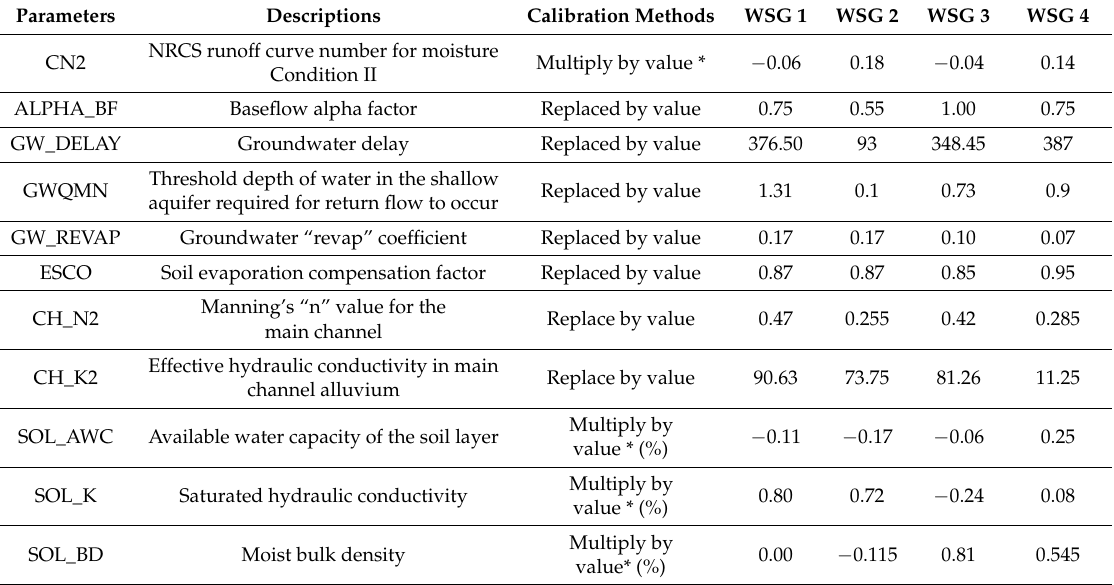
Table 2. Parameters calibrated by SWAT-CUP for WSG